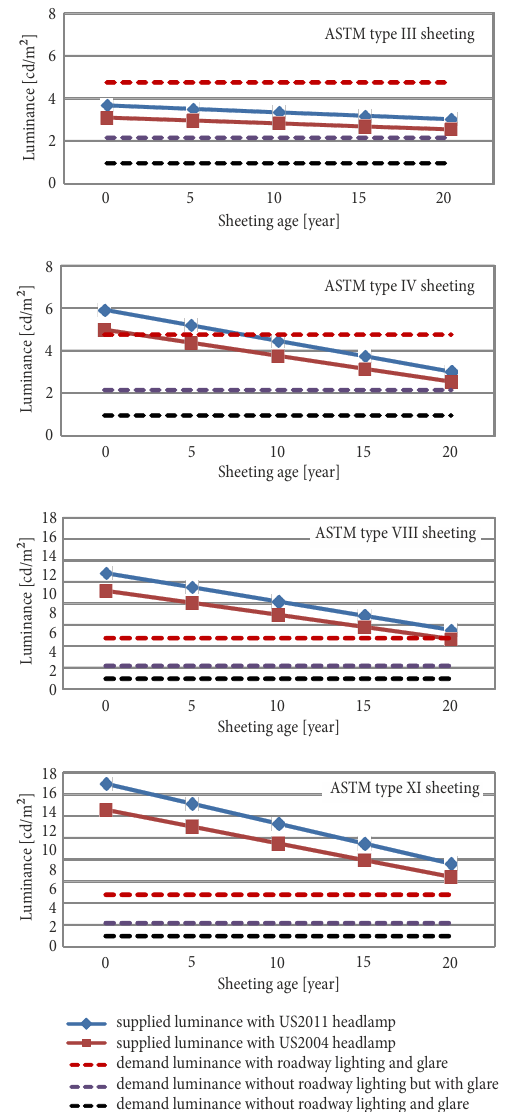
Fig. 4. Supplied luminance vs. legibility luminance for light trucks